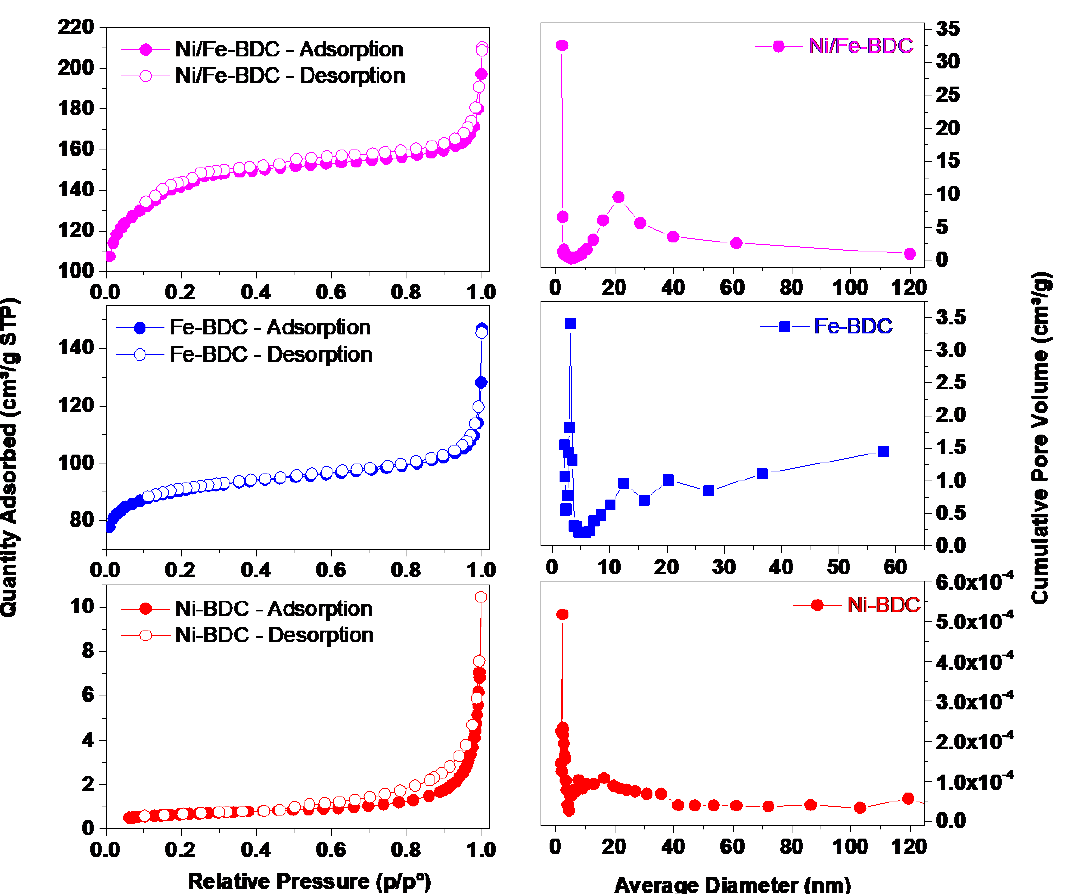
Figure 4. N 2 adsorption–desorption isotherms (left) and pore size distributions (right) of metal–organic framework (MOF)